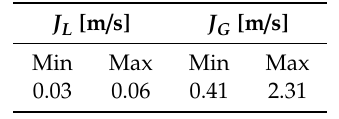
Table 3. Superficial velocity range.